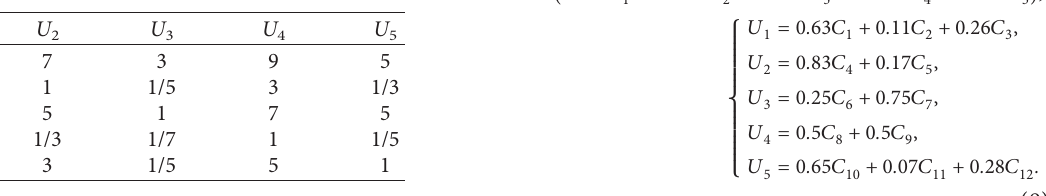
Figure 7: AHP structure model of inrush water intensity. Table 3: Primary index judgment matrix in U